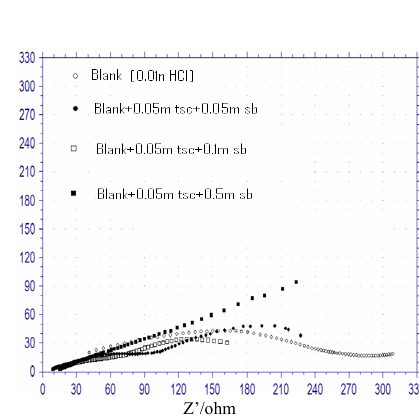
Figure 7. Nyquiste plot of mild steel